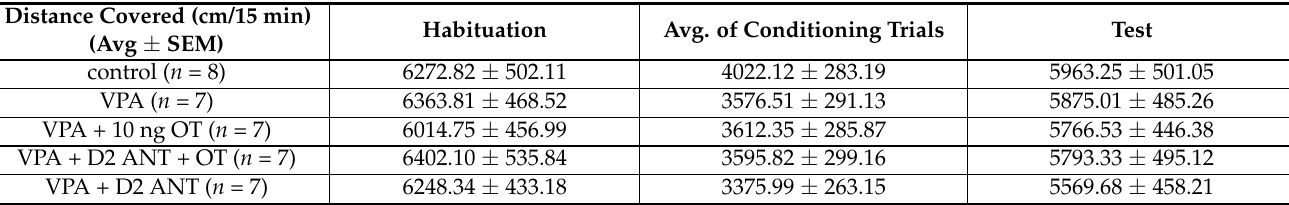
Table 2. Distance moved during the CPP trials ( ± S.E.M.) Control: neurotypical/sham male Wistar rats receiving intraamygdaloid PBS ( n = 8); VPA: intrauterine VPA-treated rats showing autistic-like behavior ( n = 7); VPA + 10 ng OT: animals showing autistic-like behavior, microinjected with 10